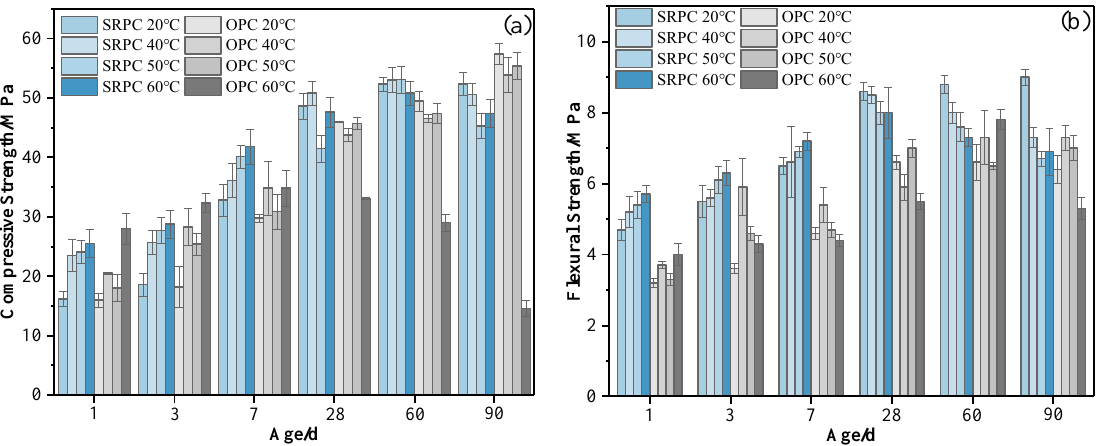
Figure 2. Variation in the specimens’ strength with age under different hydration temperatures: ( a ) compressive strength; ( b ) flexural strength. Table 3. Early strength growth rate of the SRPC under high-temperature curing (relative to 20 °C). Increasing Rate of Compressive Strength/% Increasing Rate of Flexural